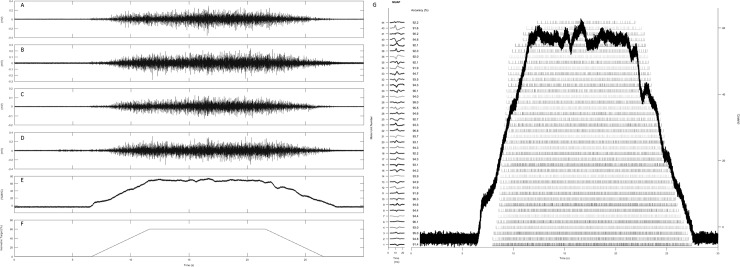
Example of raw sEMG captured concurrently on 4 channels (A—D), force output (Nm) and target (% of MVC) are also shown (in E and F, respectively). G Example of firing rate bar plot from one participant (40 motor units), vertical bars represent the firings of each motor unit. The force output trace is superimposed. Action potential shapes associated with each identified motor unit, and the results of Decompose-Synthesize-Decompose-Compare accuracy tests (%) are presented along the left vertical axis (motor units number 5, 24, 37 and 42 are absent, as they did not achieve the required accuracy %).